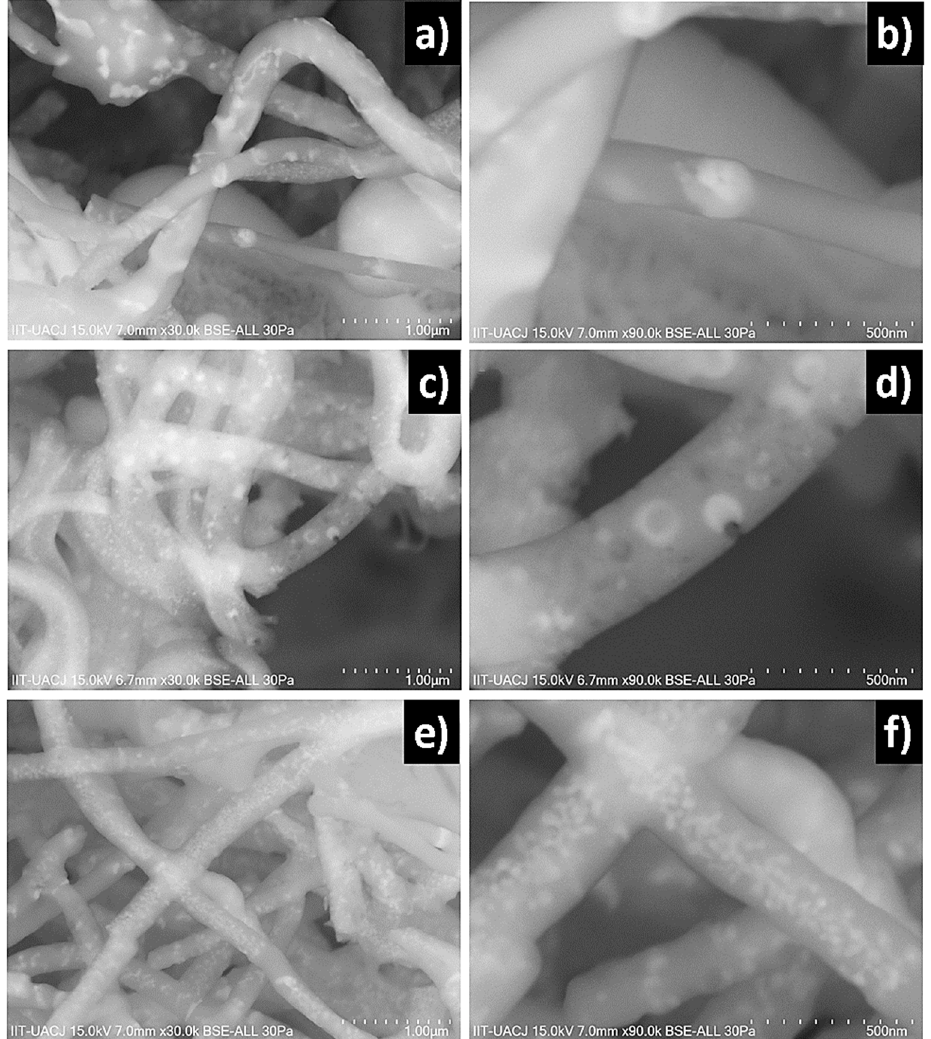
Figure 5. The SEM micrographs of LiNbO 3 /SiO 2 coaxial fibers for samples M003 (incises ( a ) and ( b )), M03 (incises ( c ) and ( d )) and M05 (incises ( e ) and ( f )) sintered at 800 °C.